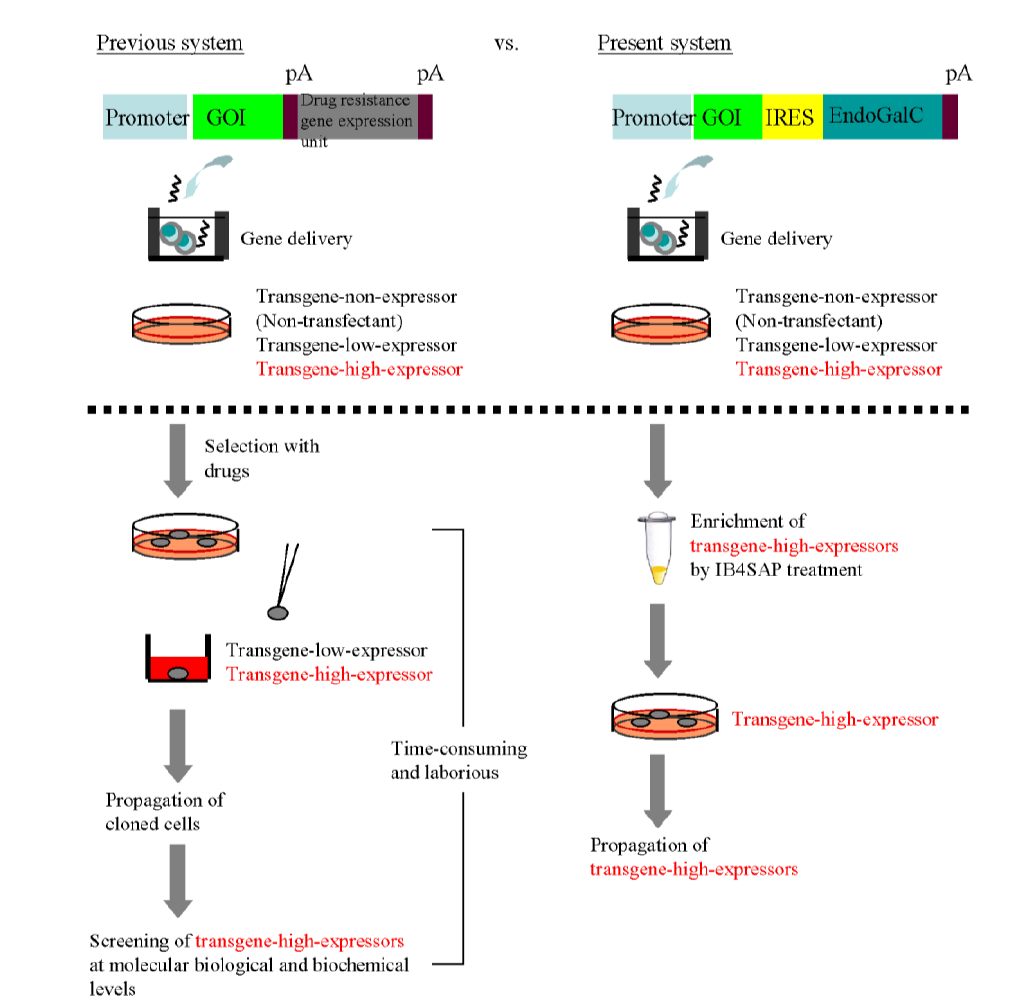
Figure 5. Comparison between the previous system for the cloning of recombinant cells and our present EndoGalC/targeted toxin-based